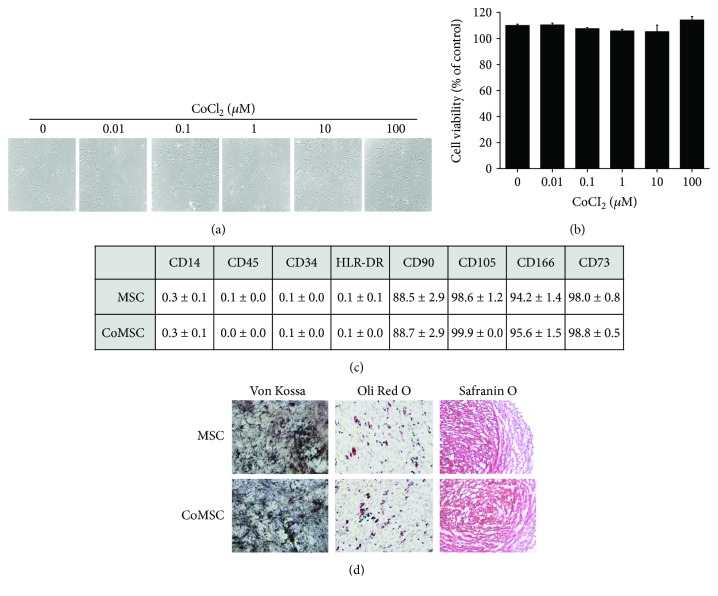
Effects of cobalt chloride (CoCl2) on the characterization of hUCB-MSCs. (a and b) The morphology and growth curve of cultured hUCB-MSCs were analyzed. hUCB-MSCs were treated with the indicated concentrations of CoCl2 for 72 hr. Phase-contrast image of hUCB-MSCs were obtained with an inverted microscope equipped with a digital camera. Cell viability was determined with the MTS assay. (c) The immunophenotypic characteristics of naïve hUCB-MSCs and CoCl2-treated hUCB-MSCs were examined by flow cytometry. (d) During incubation in specialized induction media, multilineage differentiation was measured by staining for typical lineage markers. Osteogenic, adipogenic, and chondrogenic lineages were measured by staining for von Kossa, Oil Red O, or safranin O, respectively. Data represent the mean ± SD, n = 3. MSC: naïve hUCB-MSCs; CoMSC: CoCl2-pretreated hUCB-MSCs.